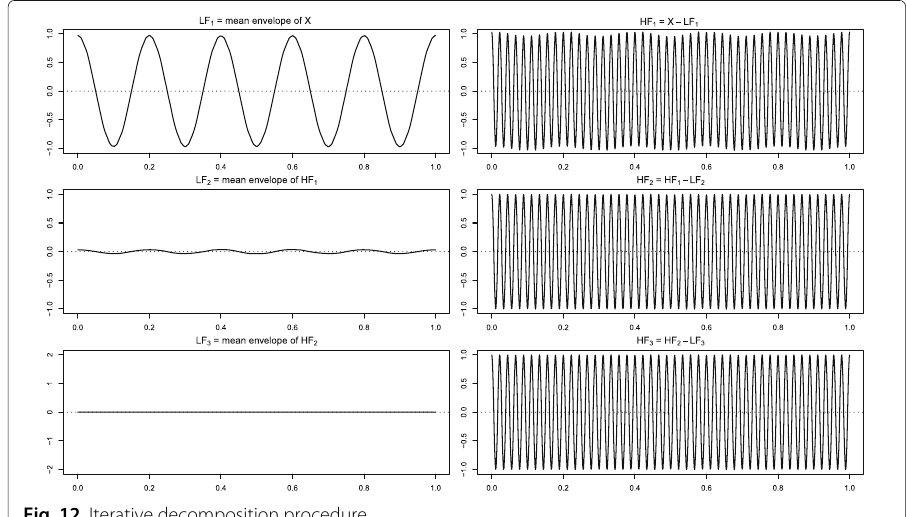
Fig. 12 Iterative decomposition